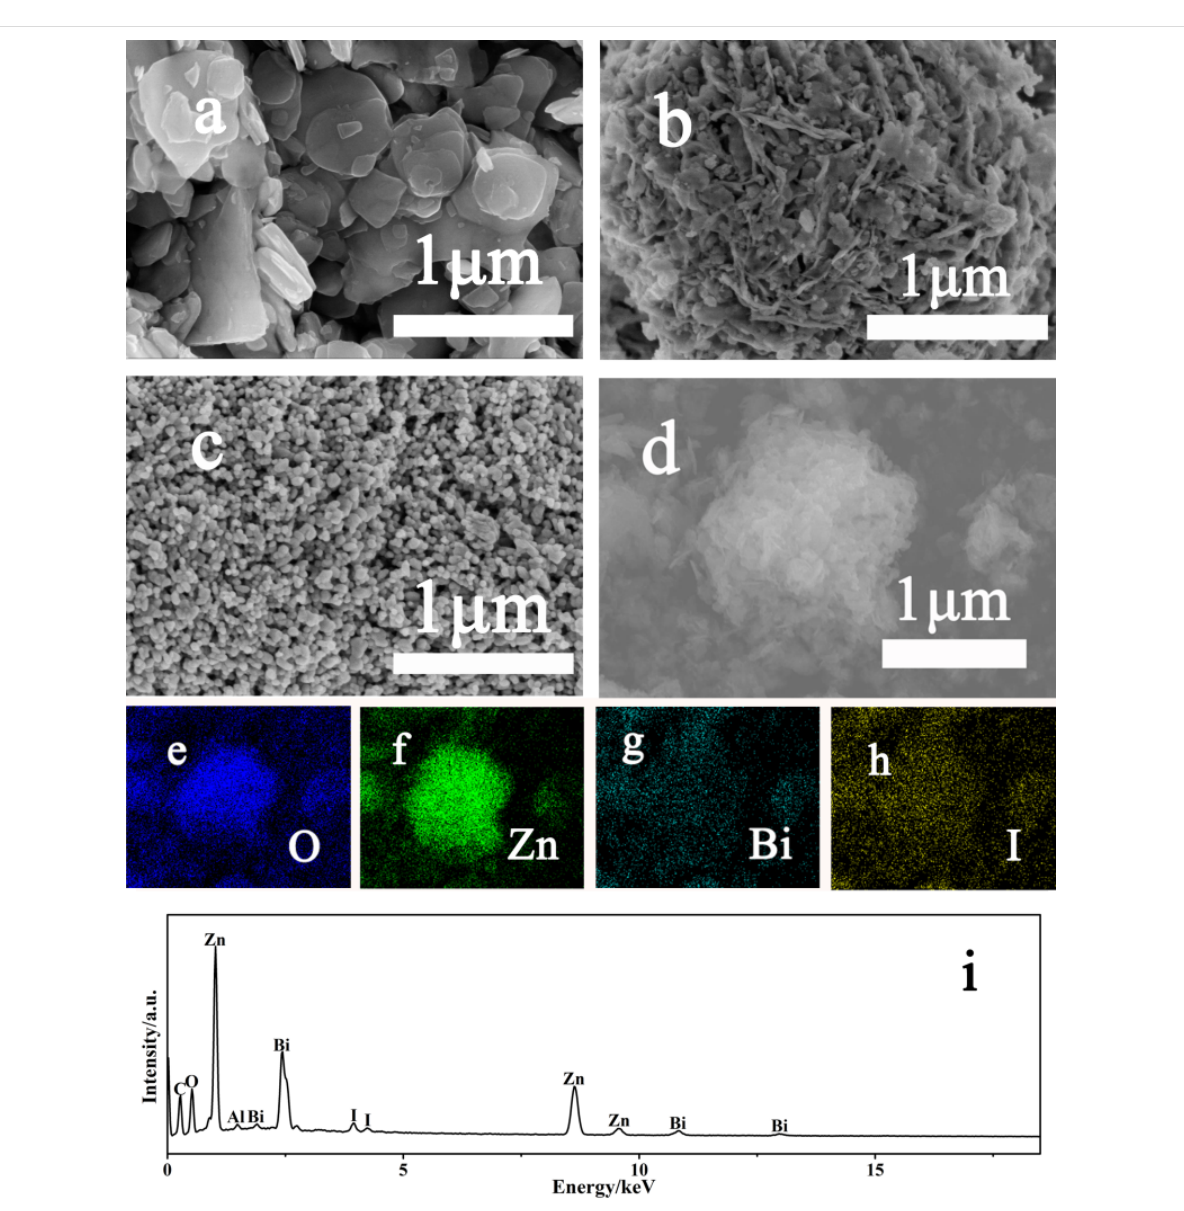
Figure 2: SEM images of sample B-1 (a), B-4 (b), B-6 (c), and B-4, (d). Energy-dispersive spectroscopy (EDS) elemental mapping of (e) O, (f) Bi, (g) Zn, (h) I, and (i) EDS of sample B-4.